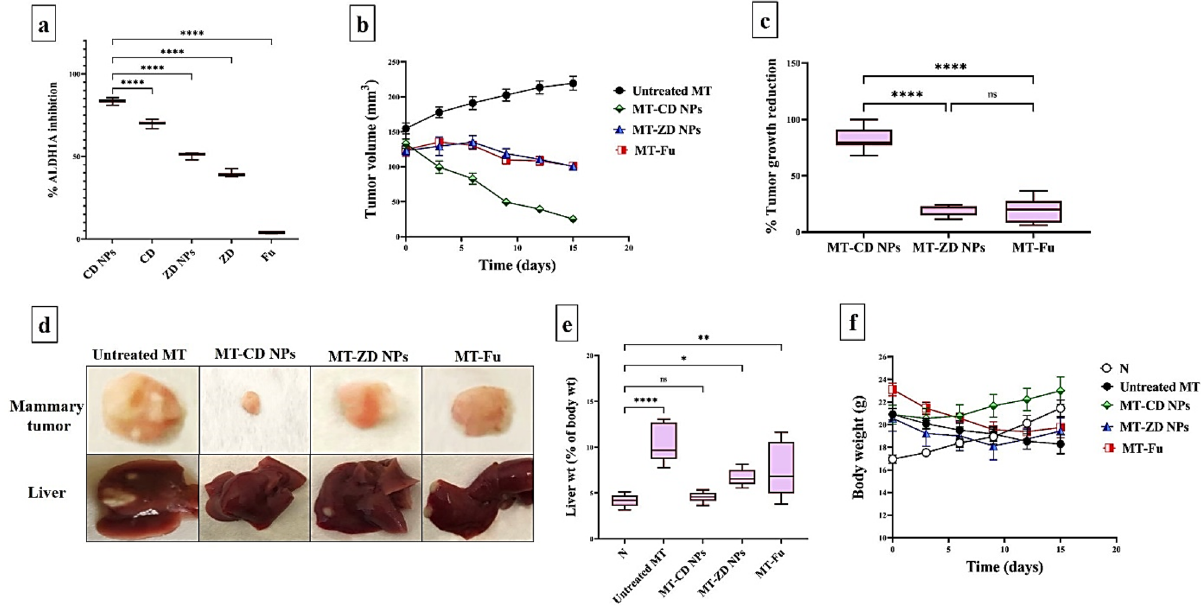
Figure 2. In vitro ALDH1A inhibitory potential and inhibitory impact on tumor growth using orthotopic mammary tumor animal model. ( a ) The relative ALDH1A inhibition in the treated MDA-MB 231 cells. ( b ) The recorded mammary tumor volume using caliper with ( c ) the reduction in mammary tumor weight that was measured, at the end of experiment, in all three treated groups compared to the untreated mammary tumor- bearing mouse group (MT). Data are demonstrated as mean ± SEM. MT-CD NPs group was compared to other groups, considering significantly different at p < 0.05*, < 0.01**, and < 0.001***. ( d ) Macroscopic images of for untreated and treated MT groups compared to N group. All values are demonstrated as mean ± SEM. Healthy (N) untreated group was compared to other groups, considering significantly different at p < 0.05*, < 0.01**, and <